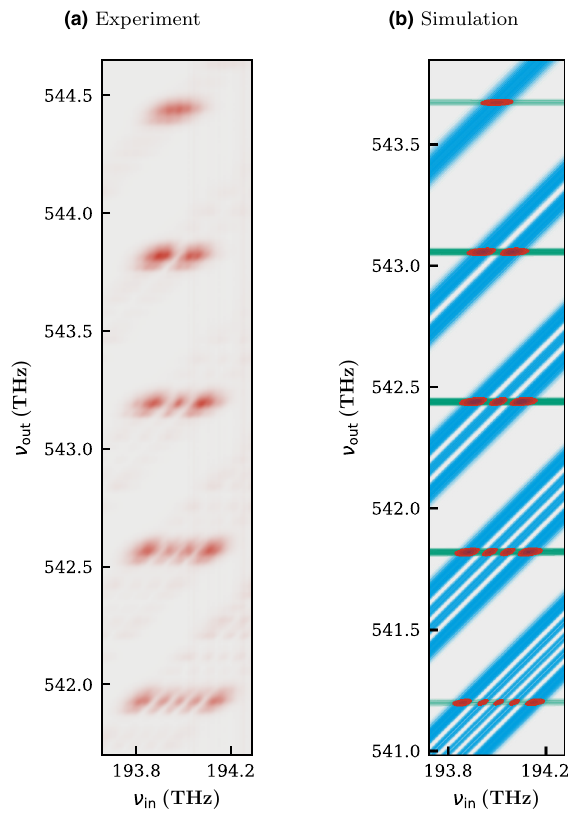
FIG. 3. The experimental (a) and simulated (b) transfer func- tion G (ν in , ν out ) (red) given by the product of a five-peak phase- matching function (cid:4)(ν in , ν out ) (cid:2) (cid:4)(ν out ) (green) and a five-peak shaped pump spectrum α(ν in , ν out ) (blue). The pump peaks